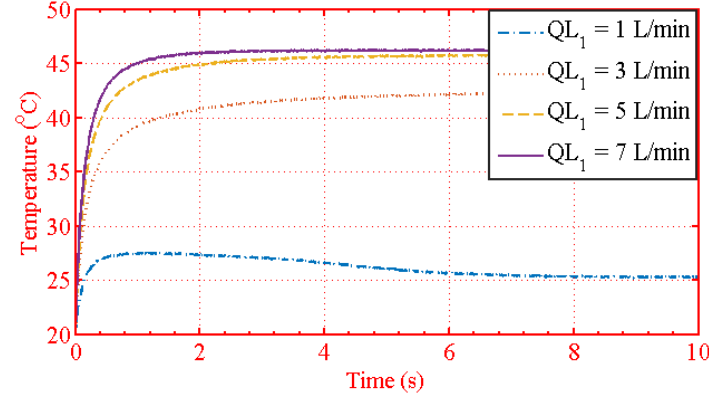
Figure 17. The output temperature in cold fluid with QL 2 = 3